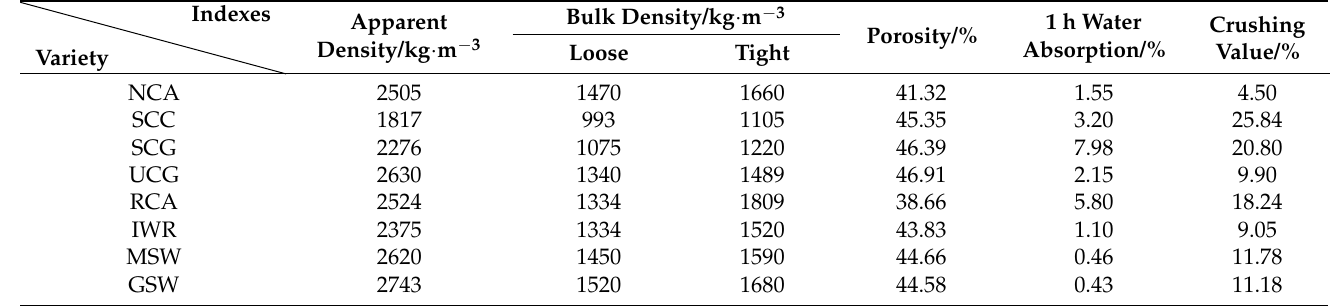
Table 1. Physical and mechanical properties of the different coarse